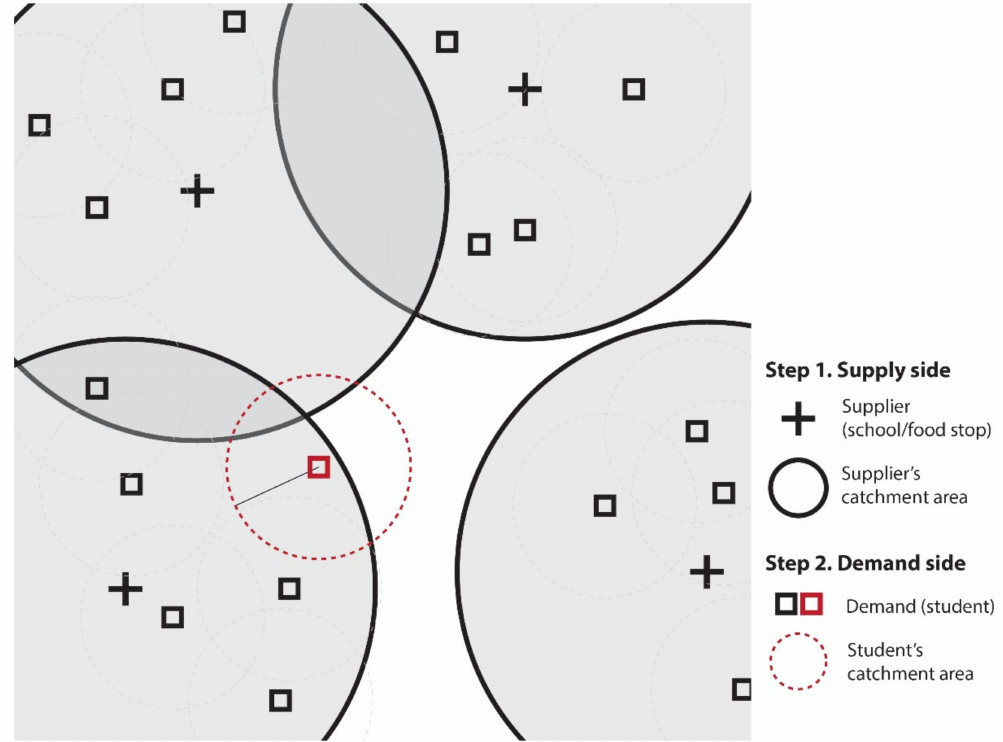
Figure 1. Study conceptualization of supply and demand dynamics using a two-step floating catchment area